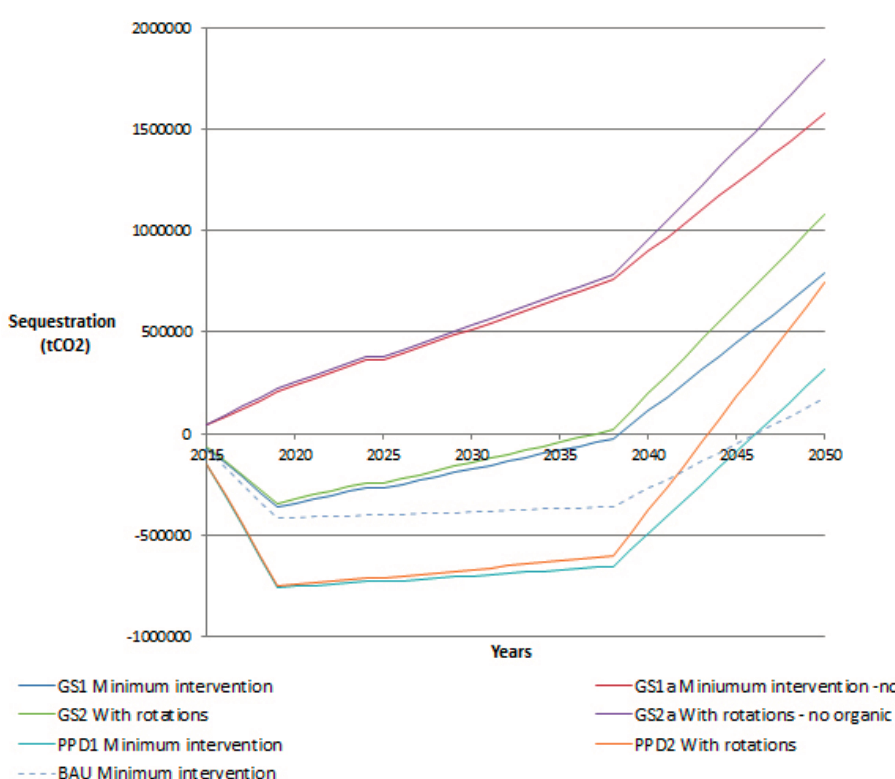
Figure 4. Sequestration pathways for each